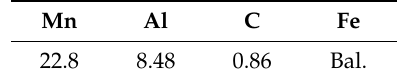
Table 1. Composition analysis of low-density steel (mass fraction,